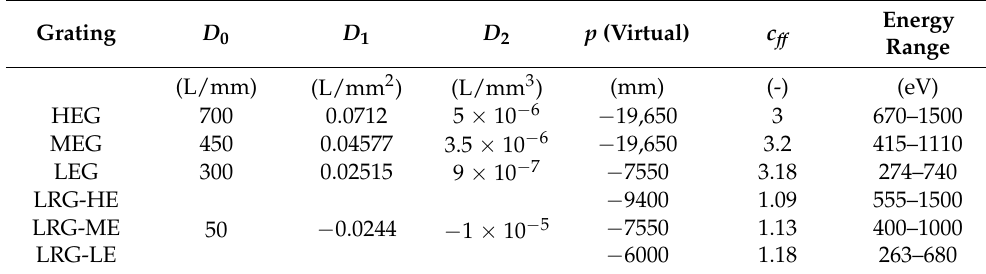
Table 1. Gratings optical parameters for the 2.2 monochromators.